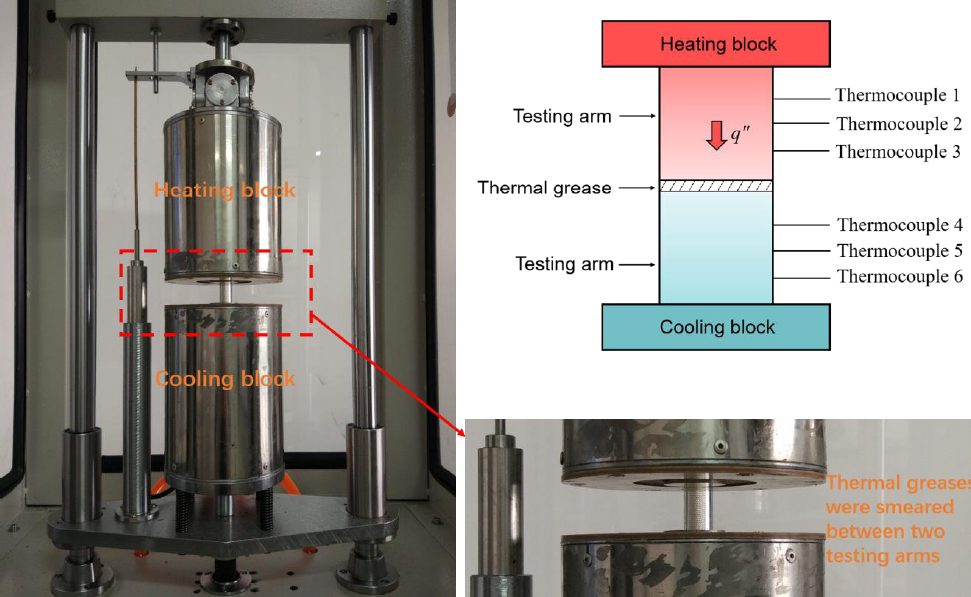
Figure 10. Working principle of DRL-III steady state device used for thermal interfacial resistance measurement.